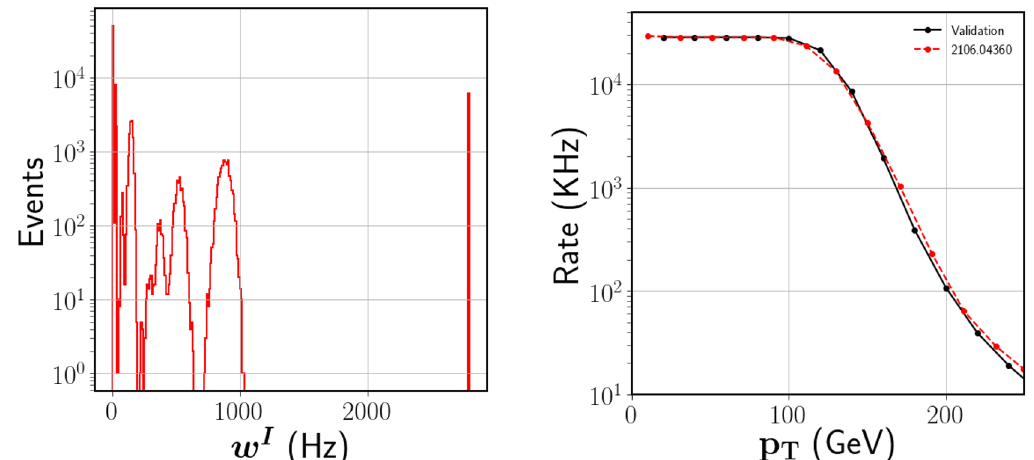
Figure 14 . Event weight in terms of rate for QCD events ( left ) and rate of the single jet trigger at HL-LHC using the “stitching” procedure, validated with ref. [89] ( right